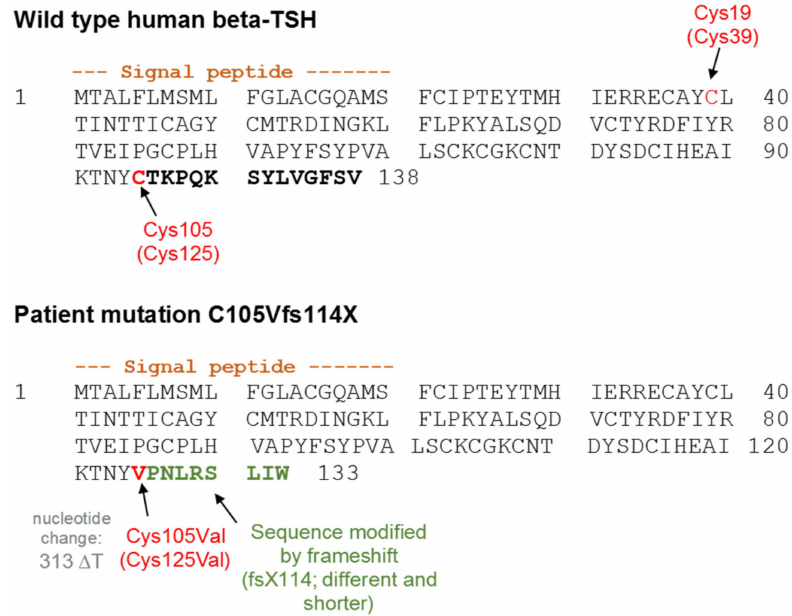
Figure 1. Comparison of the sequence of WT human TSHB and the patient mutation C105Vfs114X. Cysteine 19 and the cysteine at position 105 usually form a disulfide-bridge in WT TSH and are shown in red. The T-deletion and the resulting frameshift of the patient mutation leads to a replacement of the cysteine at position 105 by a valine (also shown in red). In addition, the following amino acids of the mutation (shown in green) di ff er from the WT (shown in bold black) and a premature stop results at position 114. Numbering with signal peptide is shown in